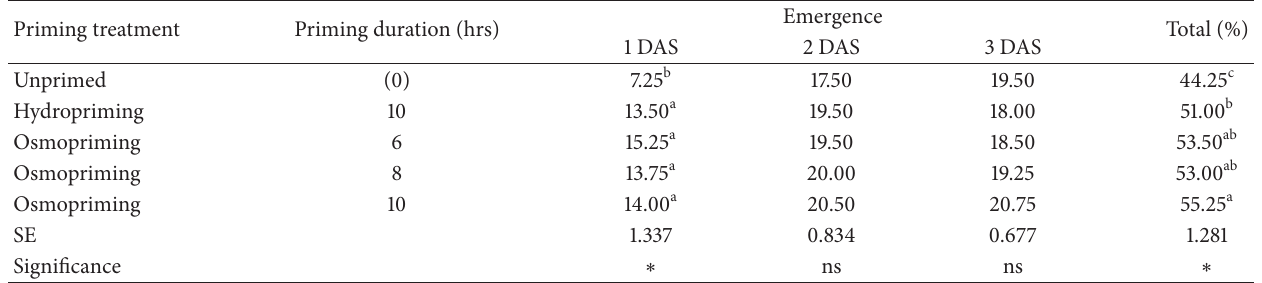
Table 2: Effect of seed osmopriming duration on emergence of cowpea seedlings.